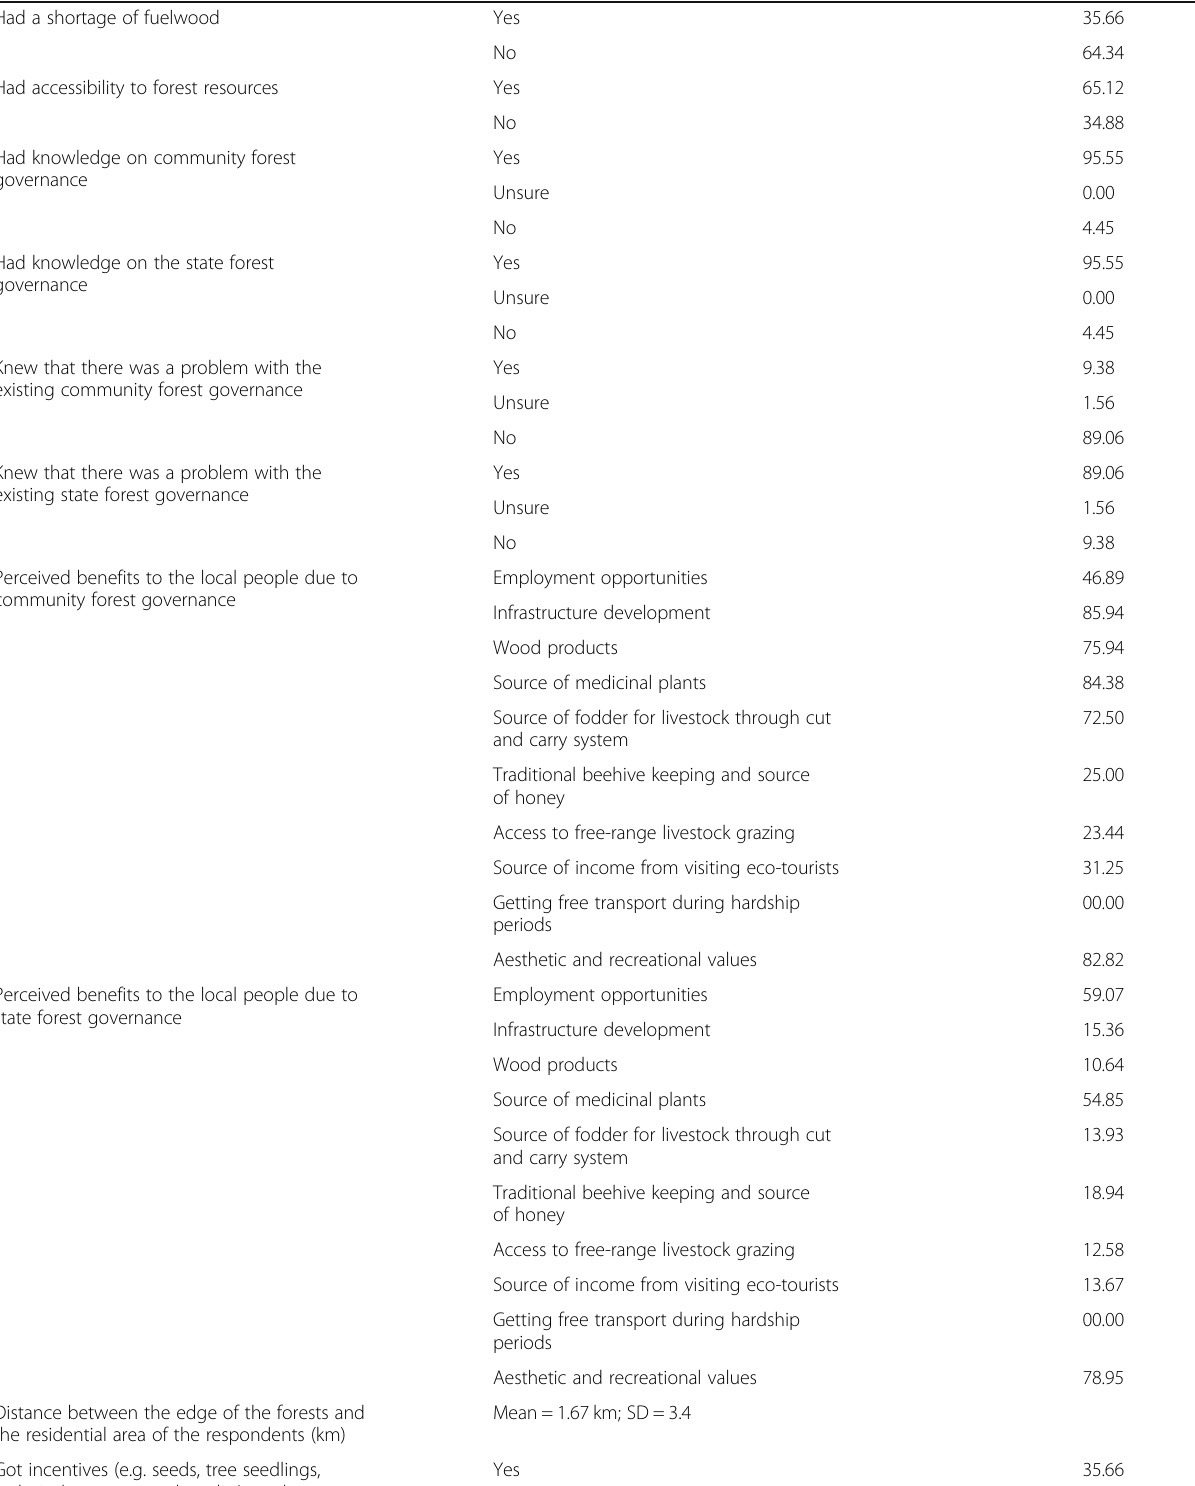
Table 1 Socioeconomic characteristics and descriptive results